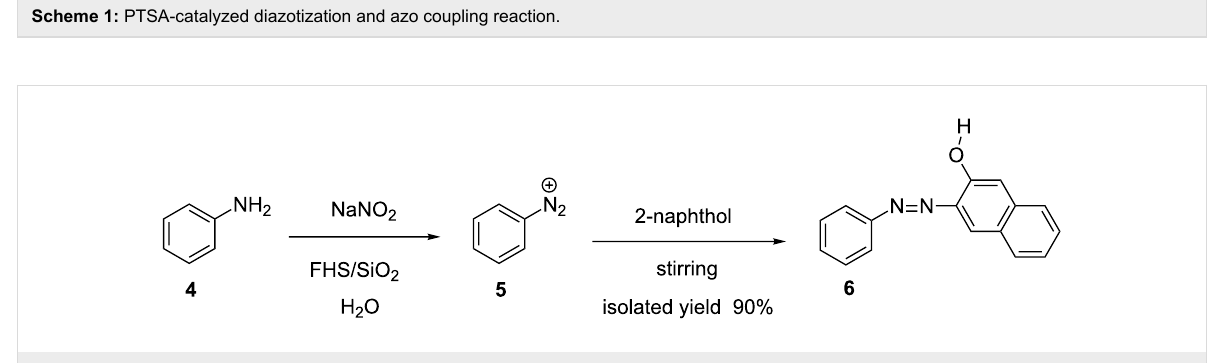
Scheme 2: Ferric hydrogen sulfate (FHS) catalyzed azo compound synthesis.